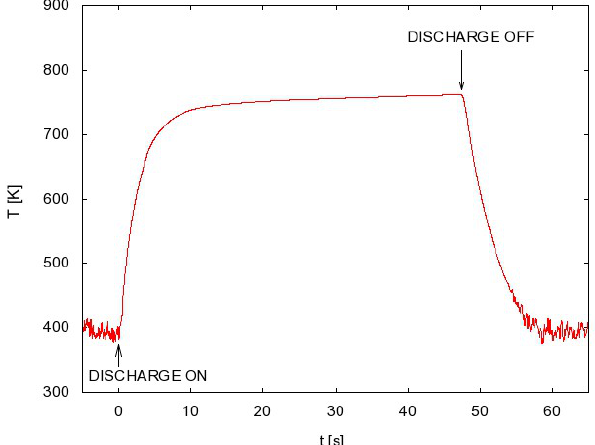
Figure 2. A typical measurement of the probe temperature versus time at a pressure of 55 Pa and a discharge power of 1.2